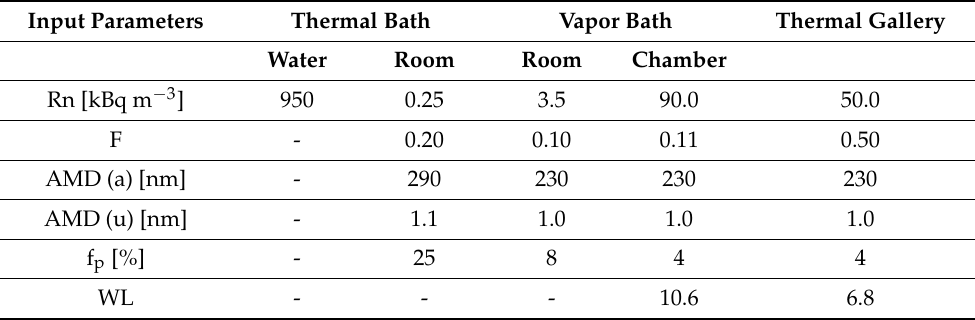
Table 1. List of input parameters for the dose calculations in the thermal bath, vapor bath, and thermal gallery: Radon activity concentration (Rn), equilibrium factor (F), activity median diameters (AMD) for attached (a) and unattached (u) radon progeny, unattached fraction of the PAEC (f p ), and Working Level